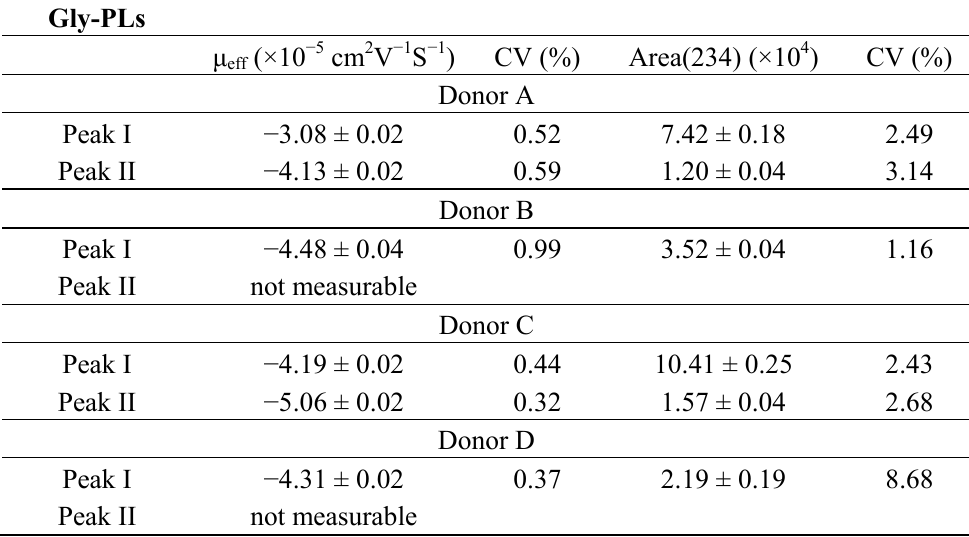
Table 10. The average effective mobility and peak area of in vitro glycated VLDL phospholipids analyzed by MEKC at absorbance 234 nm (data are means ± SD of four